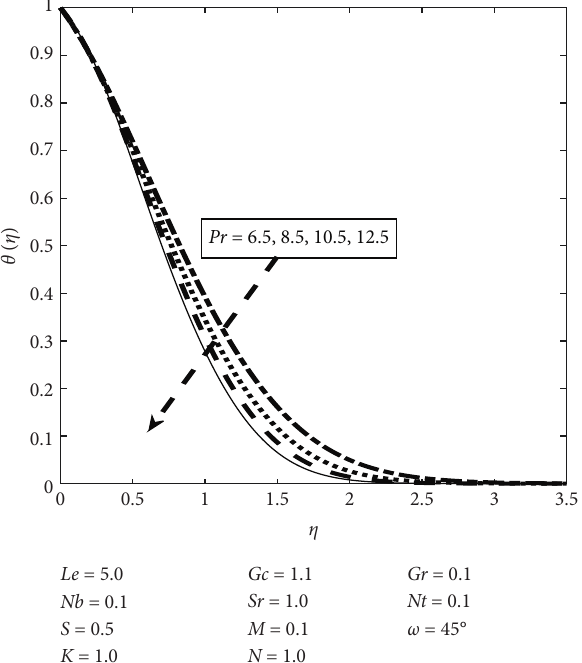
Figure 10: Temperature profile for several values of Pr .